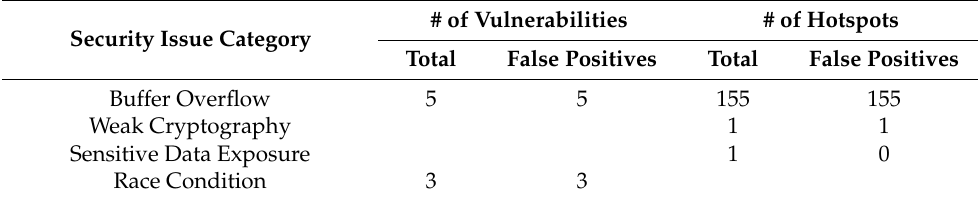
Table 16. Number of security issues of different categories in the thttpd